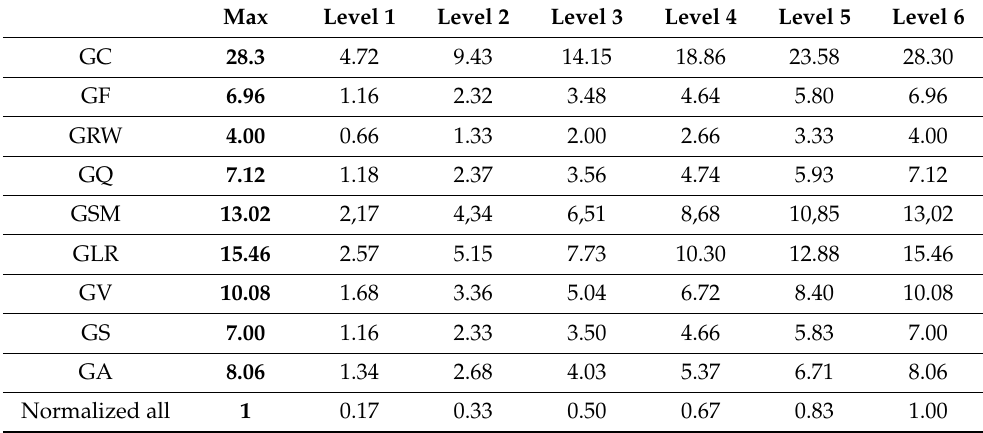
Table 4. Maximum values of the CHC domains for individual game